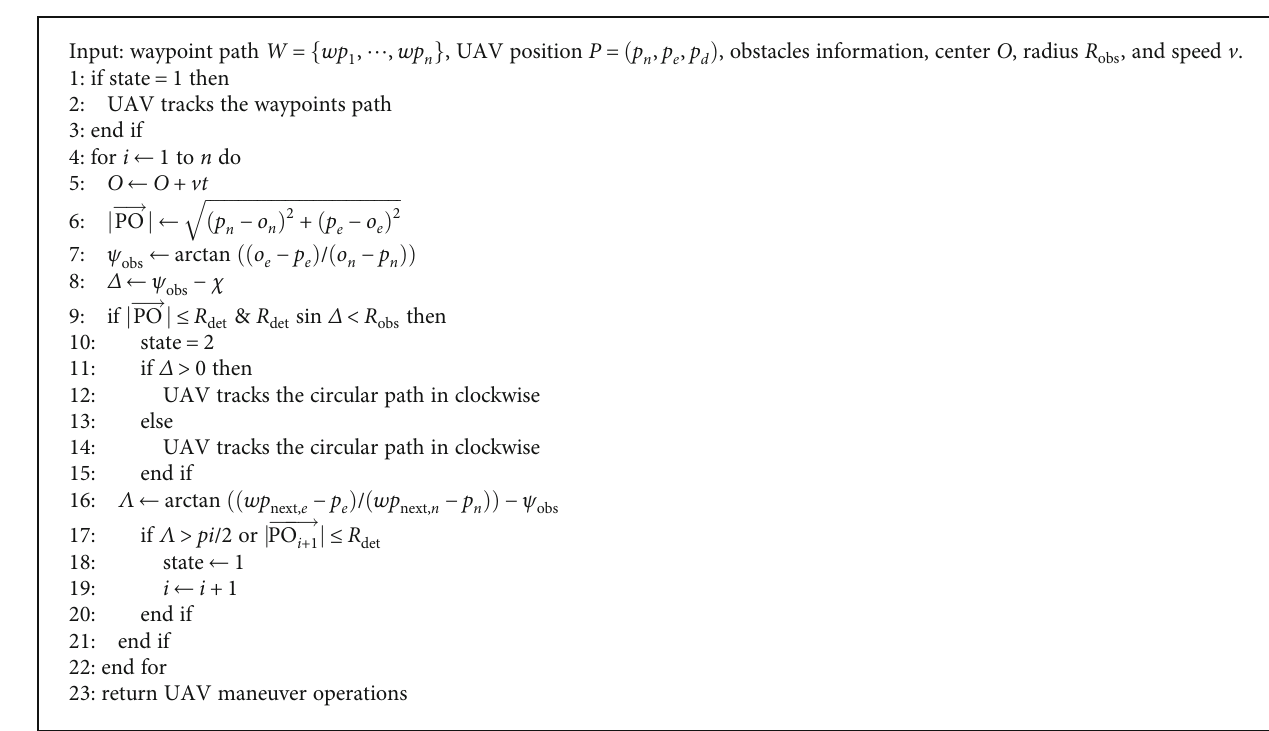
Algorithm 1: The CTGA